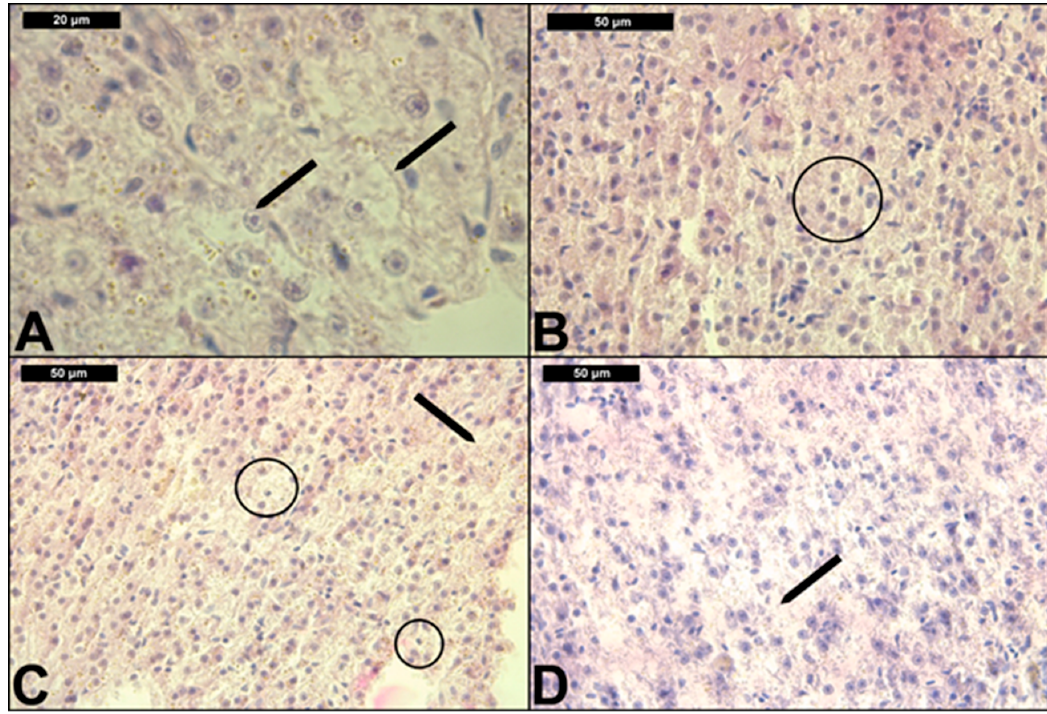
Figure 2. Histopathological alterations in the liver of common carp after the exposure with decreasing CPF concentrations based on Directive 2013/39/EU of the European Parliament and of the Council (0.03 μ g/L). ( A ) Initial process of lipid accumulation (scale bar 20 μ m) H&E; ( B ) granular degeneration (scale bar 50 μ m) H&E; ( C ) necrosis (scale bar 50 μ m) H&E; ( D ) nuclear alterations—karyolysis (arrow) and karyopyknosis (scale bar 50 μ m) H&E.